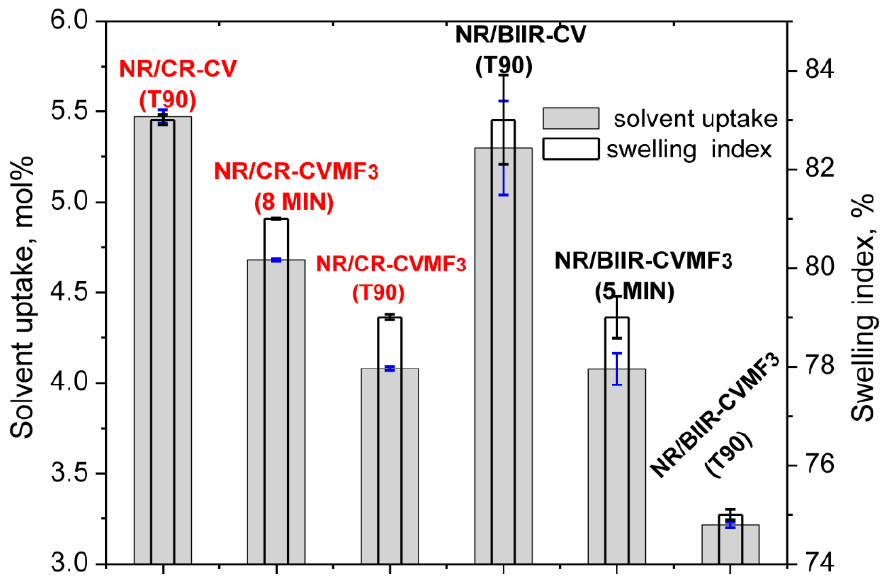
Figure 7. Equilibrium swelling index and the solvent uptake of the blends molded at different curing time.